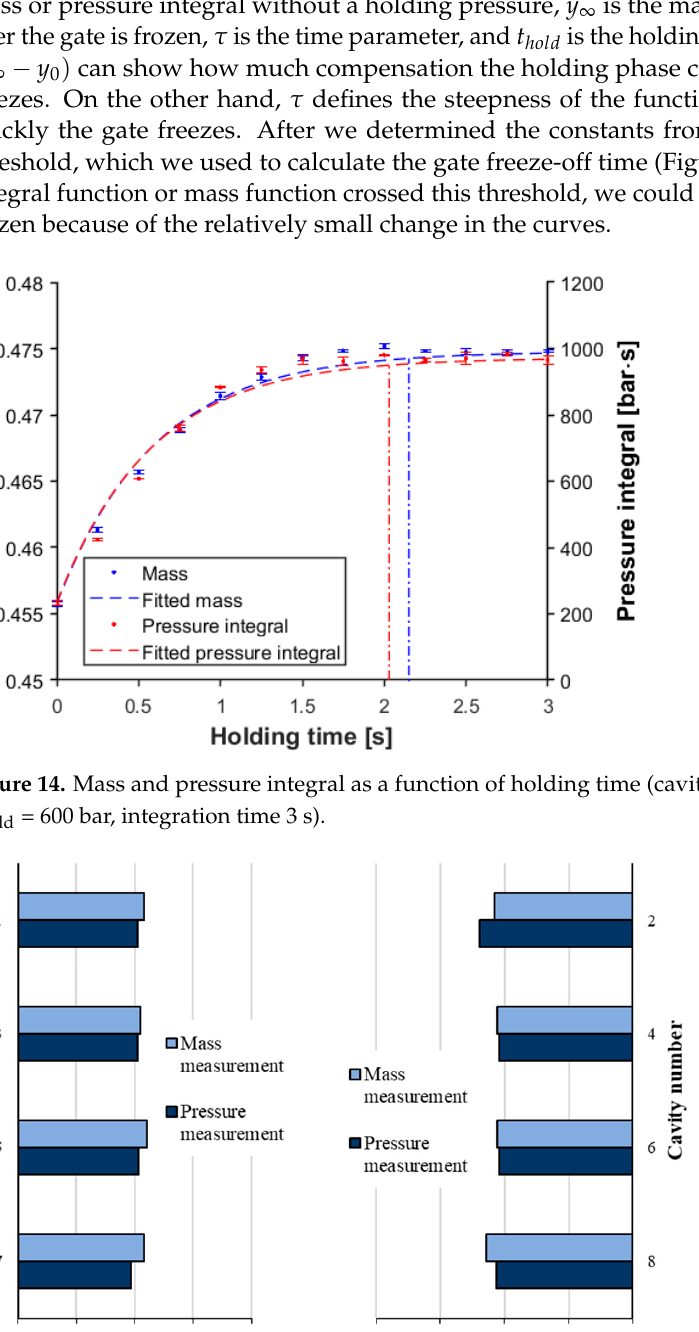
Figure 13. Relationship between the pressure integral and sample mass (R = 0.973 with a significance level of 0.05).